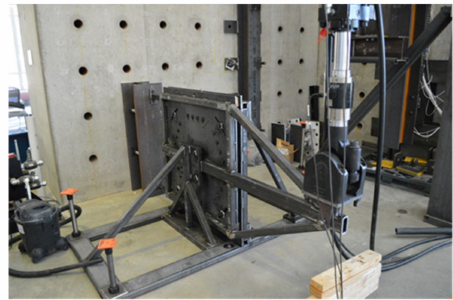
Figure 13. Shear test fixture with “SR3” paver installed in EMSTL.